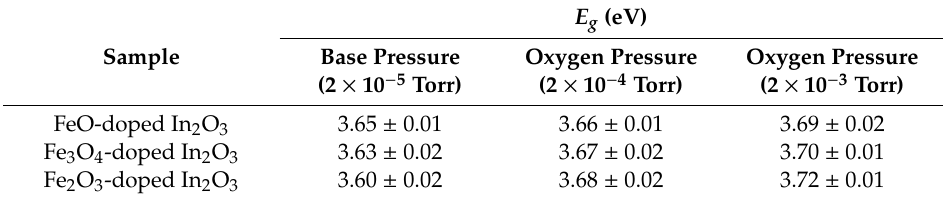
Table 3. Summary of the band gap values of Fe-doped In 2 O 3 thin films deposited at the base and higher oxygen